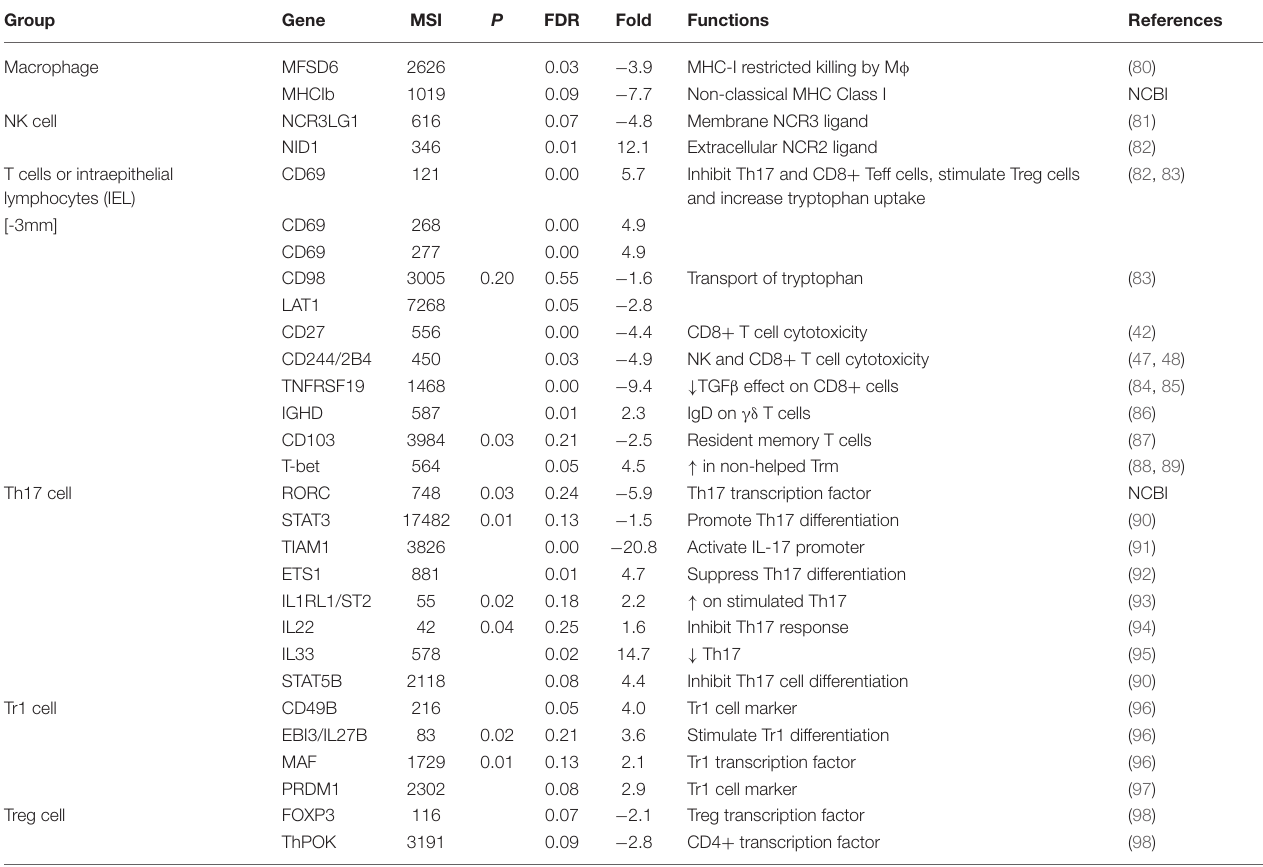
TABLE 6 | Mean expression levels (microarray signal intensity, MSI), false discovery rates (FDR) and fold differences ( + and –values as up- and down-regulated in carriers compared to non-carriers, respectively) of genes regulating or expressed on immune cells. Group Fold